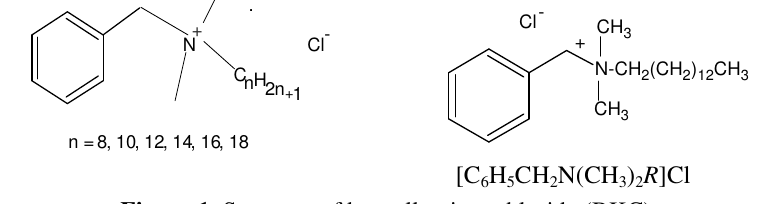
Figure 1. Structure of benzalkonium chloride